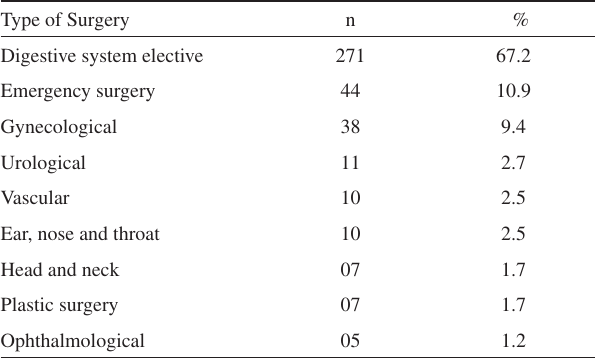
Table 2 – Surgical types evaluated